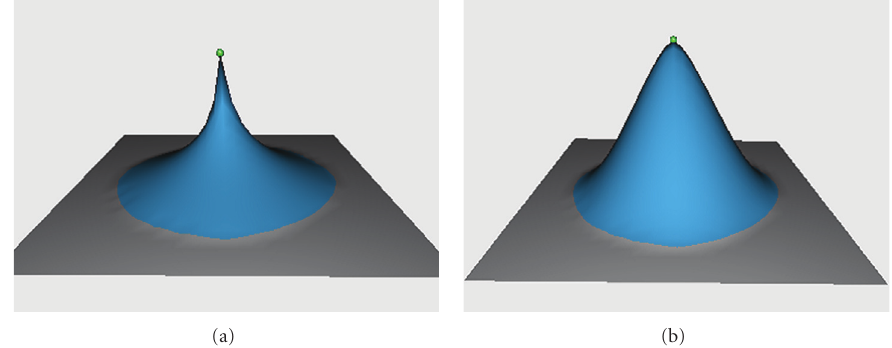
Figure 1: The surface is deformed by minimizing elastic surface energy subject to the user constraints. The gray area is the fixed region F , and the blue area is the free region. The vertex in green is the handle vertex H . (a) Pure stretching ( k s = 1, k b = 0), (b) pure bending ( k s = 0, k b = 1).